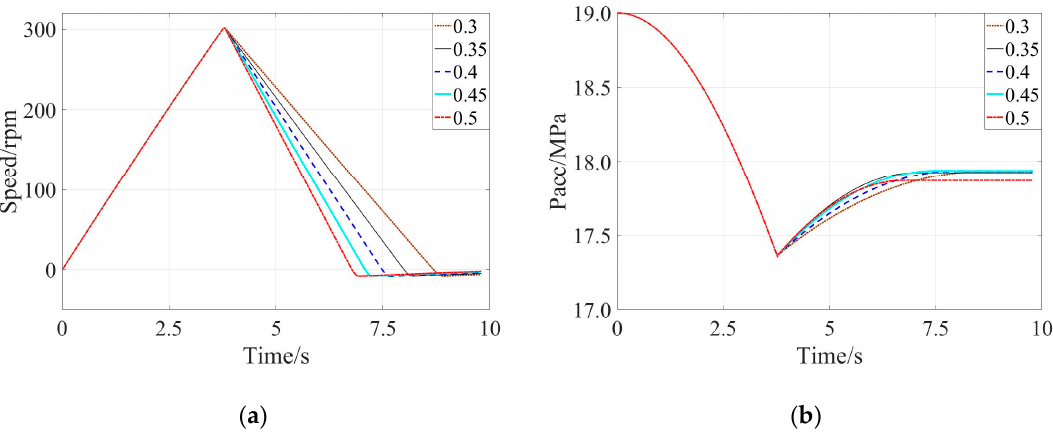
Figure 5. Simulation results with the different braking intensity: ( a ) Evolution of speed of the flywheel, ( b ) Evolution of pressure of the accumulator.